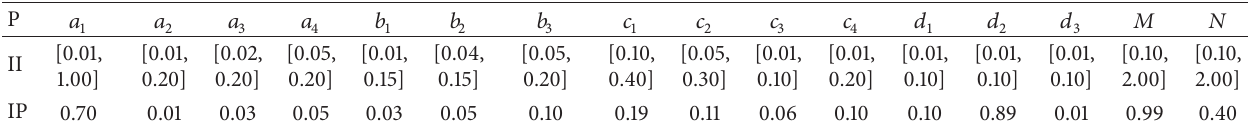
Table 2: The parameters’ initial intervals and identified values. P stands for parameters, II stands for initial intervals, and IP stands for identified parameters.